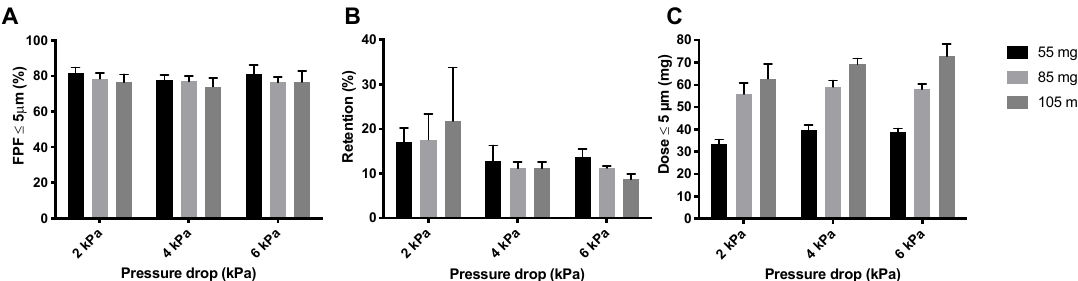
Figure 12. The inhaler dispersion results for three di ff erent nominal doses of isoniazid pellets produced at 400 mbar. Panel ( A ) shows the FPFs, panel ( B ) shows the inhaler retention and panel ( C ) shows the FPD (average ± SD, n = 5). The FPD is calculated by multiplying the FPF with the emitted dose ( = FPF × (1 − retention)). The three di ff erent nominal doses used were, 55 mg (55.82 ± 0.25 mg), 85 mg (86.01 ± 0.72 mg), and 105 mg (105.30 ± 1.17 mg).